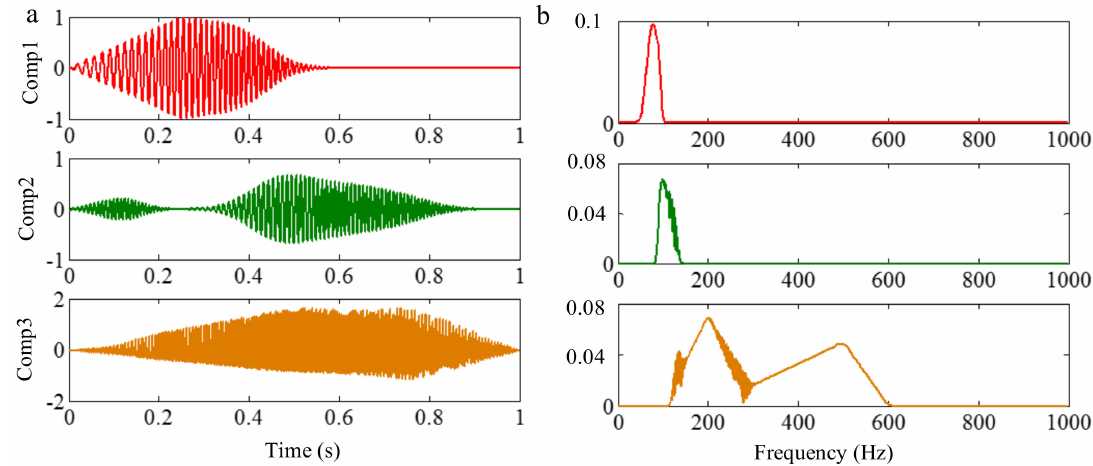
Figure 29. The waveforms of EWT result of f sig 6 and the corresponding Fourier spectrums: ( a ) waveforms and ( b ) Fourier spectrums.